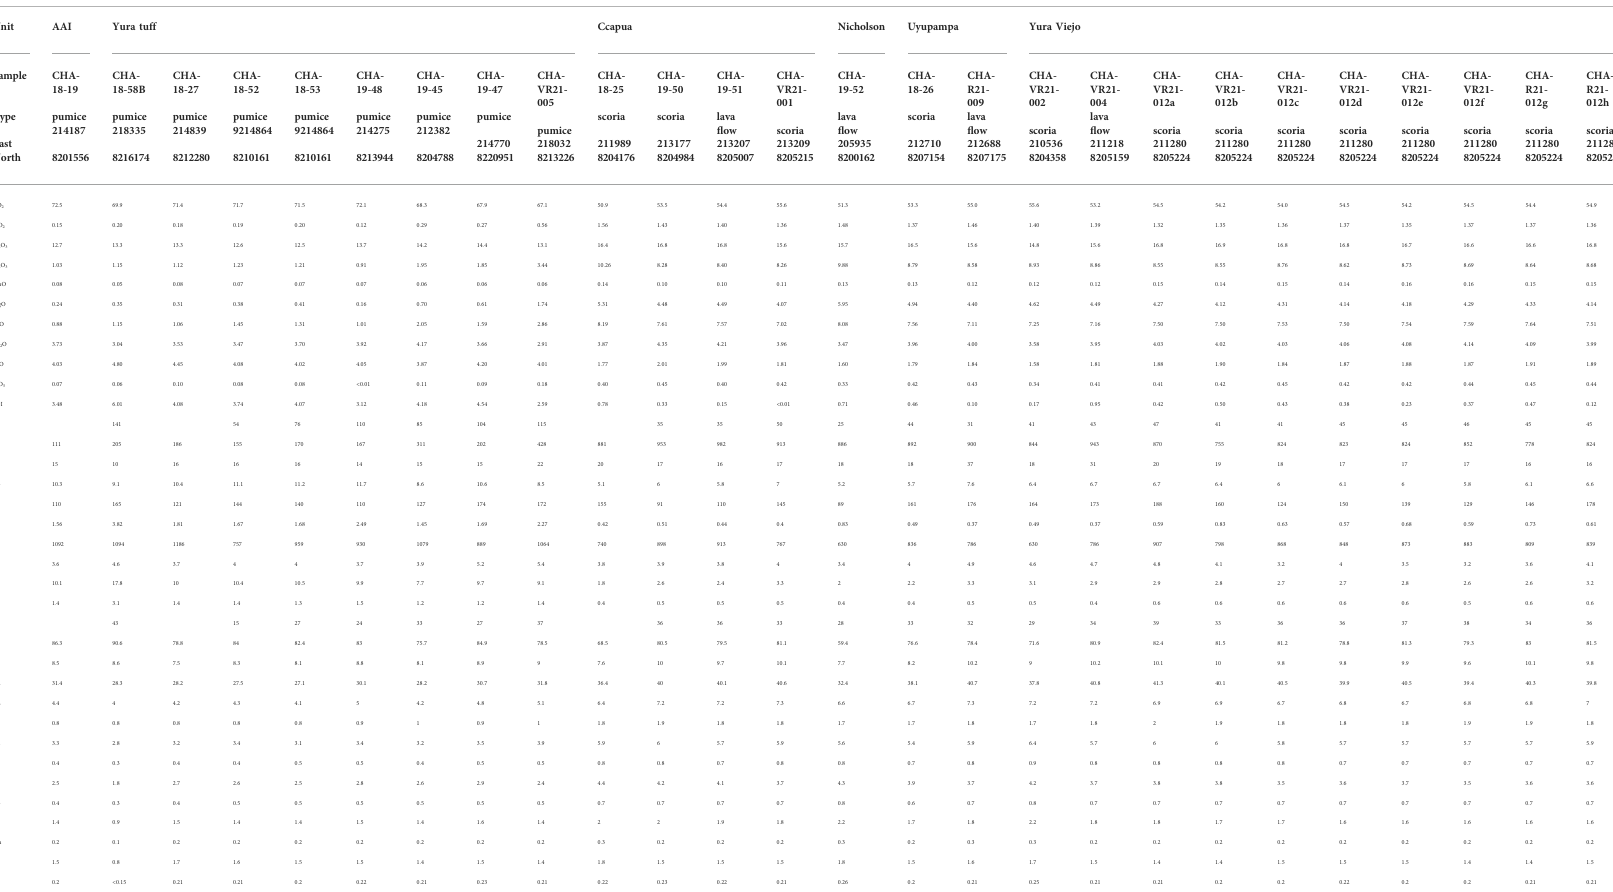
TABLE 3 Major, trace and REE analyses of samples from Arequipa Airport Ignimbrite (AAI), Yura Tuff and Yura Monogenetic Field obtained during this work. All Fe is given as Fe 2 O 3 . The coordinates of the sample locations are indicated in UTM WGS84, Zone 19S. Unit AAI Yura tuff